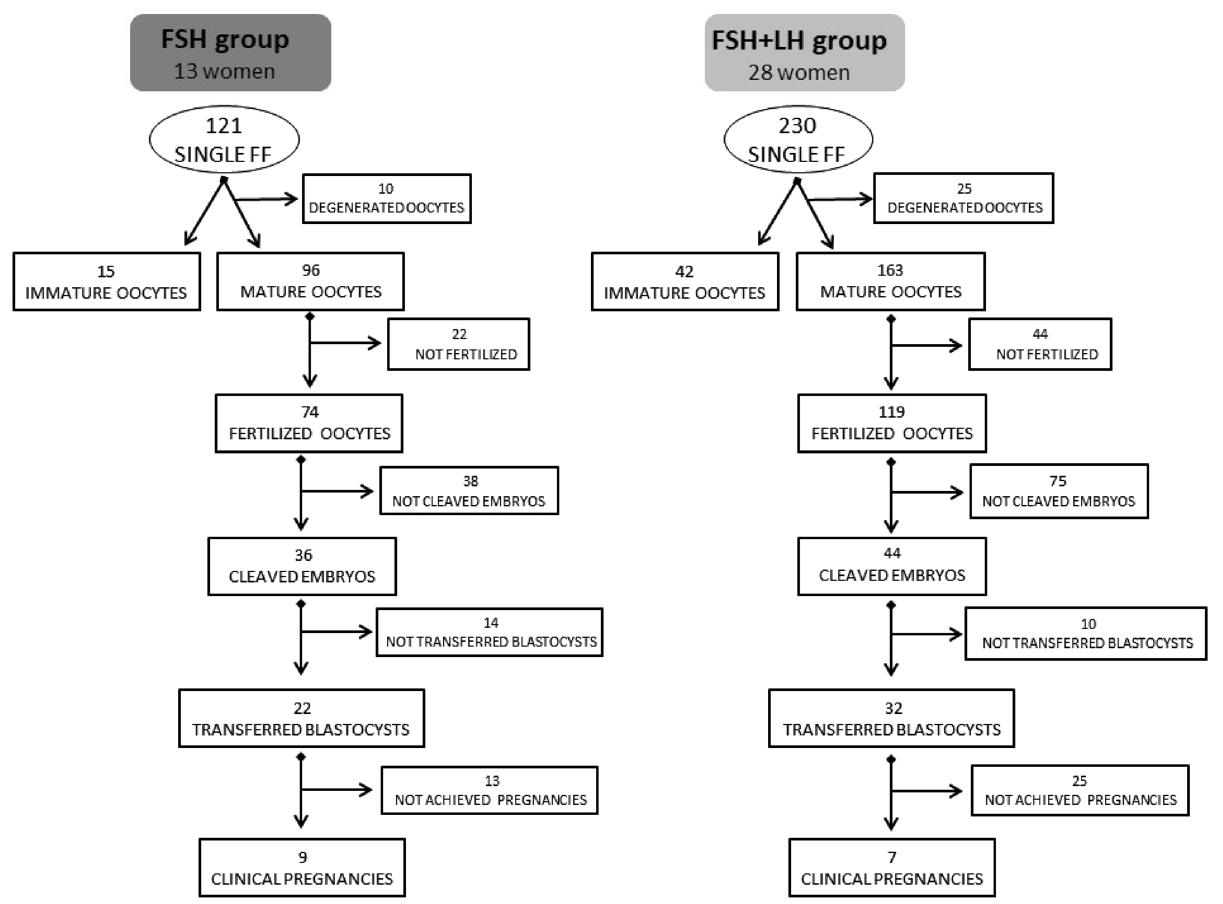
Figure 1. Flowchart of the fate of the single collected oocytes in the two groups of ovarian stimulation. Analyses were performed on 111 FF in FSH group and on 205 FF in FSH + LH